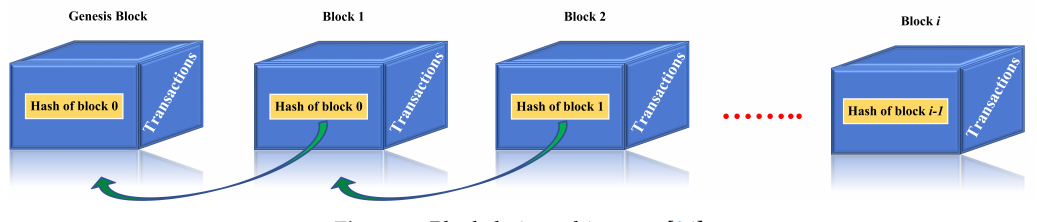
Figure 2. Blockchain architecture